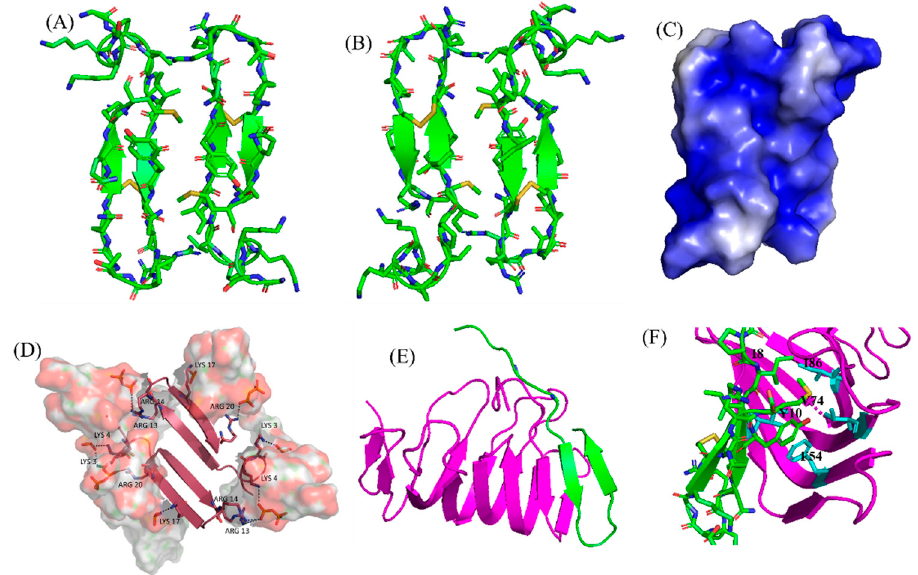
Figure 4. ( A , B ) Dimeric β -sheet structure of thanatin as a complex of LPS micelle in two different orientations [87,91]. ( C ) Molecular surface electrostatic potential of the dimeric structure of thanatin in LPS micelles (pdb: 5XO9), colored according to residue type. Blue, cationic and white, non-polar residues [87]. ( D ) Molecular docking of thanatin dimer with LPS highlighting interactions of cationic resides with negatively charged phosphate head groups of LPS [87]. ( E ) NMR derived structure of thanatin/LptA m complex (pdb: 6GD5). Thanatin is in green and LptAm is in purple ribbon. ( F ) The N-terminal beta-strand, residues P7-N12, of thanatin is in proximity with the N-terminal beta-strand of LptA m jellyroll beta-structure. A parallel organization of the two beta-strands is maintained by close packing of thanatin residues I8, Y10, and M21 with a set of non-polar/aromatic LptA m residues [92] .